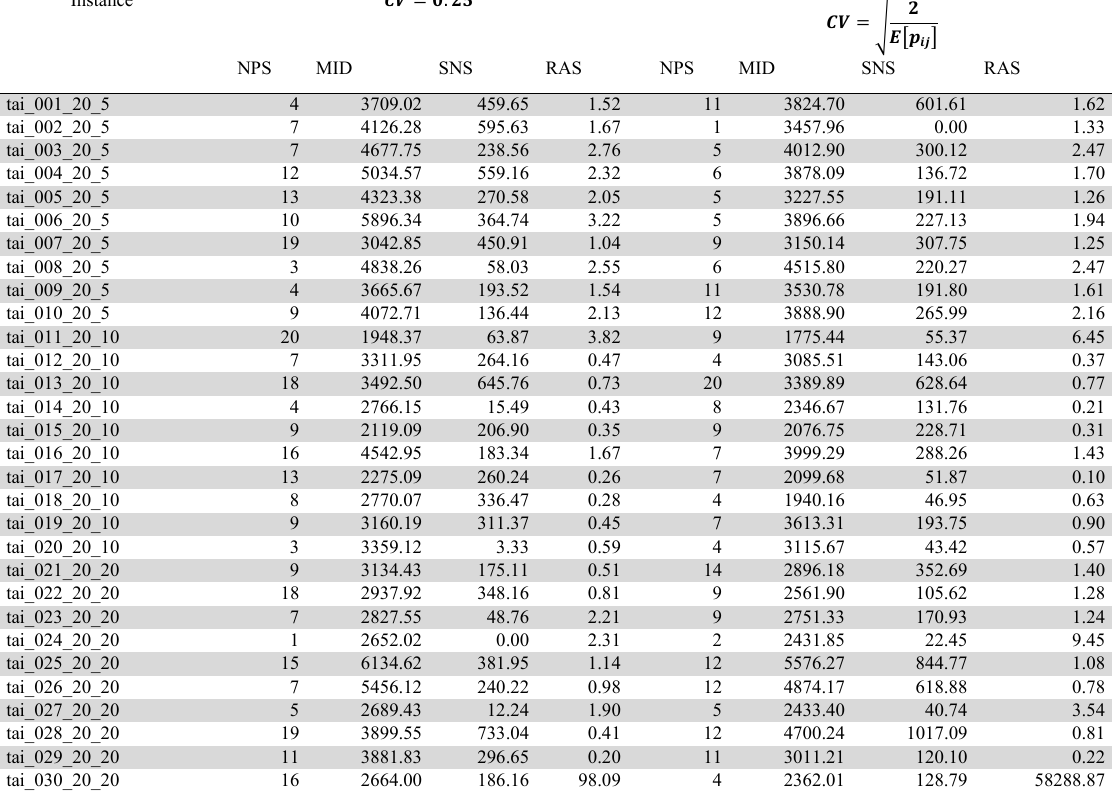
Multi-objective indicators for instances of 20 jobs